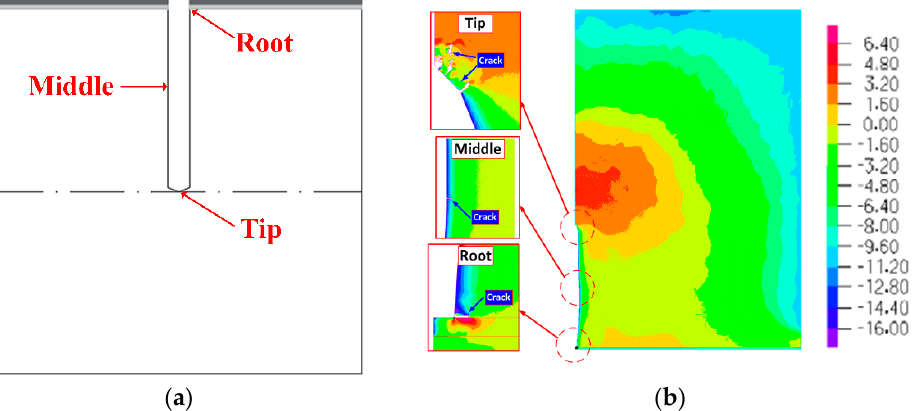
Figure 15. ( a ) Different positions of perforation; ( b ) stress field after fracture initiation simulated by Hu et al. [23].